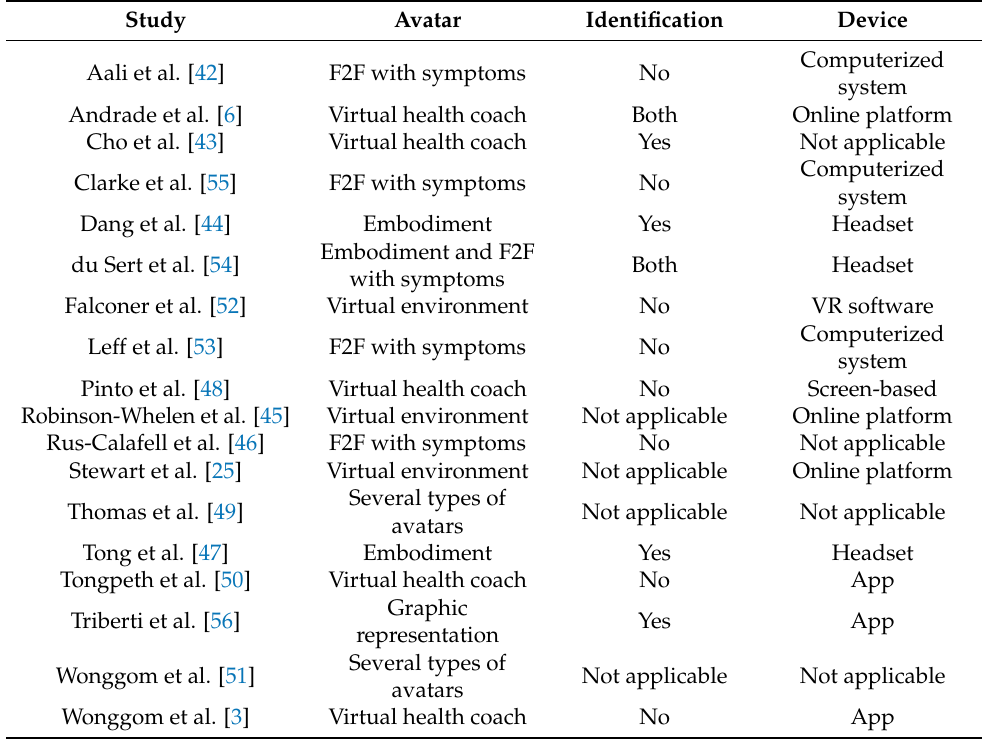
Table 3. Types of avatars, users’ identification with the avatars, and